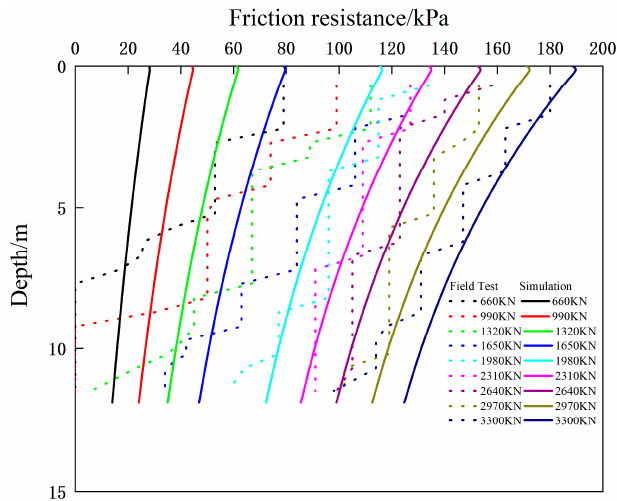
Figure 10. Friction resistance between the stiffened core and cemented soil.